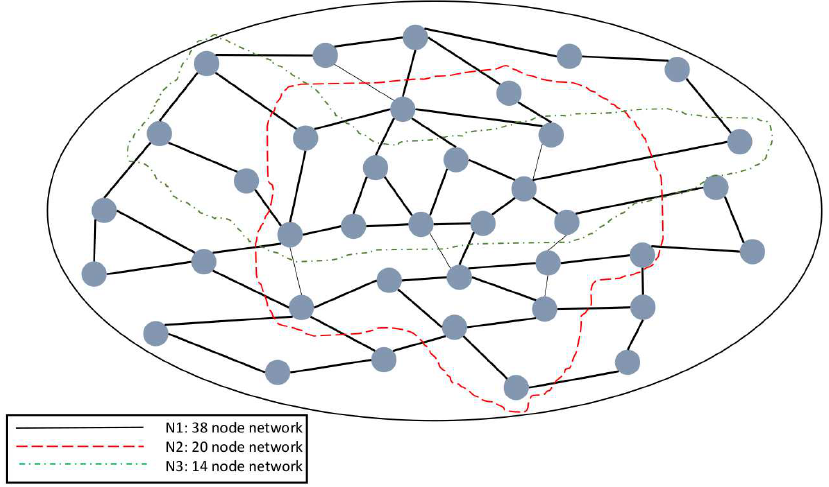
Figure 2. N 38 , N 20 , and N 14 C-RAN topology for numerical evaluations.